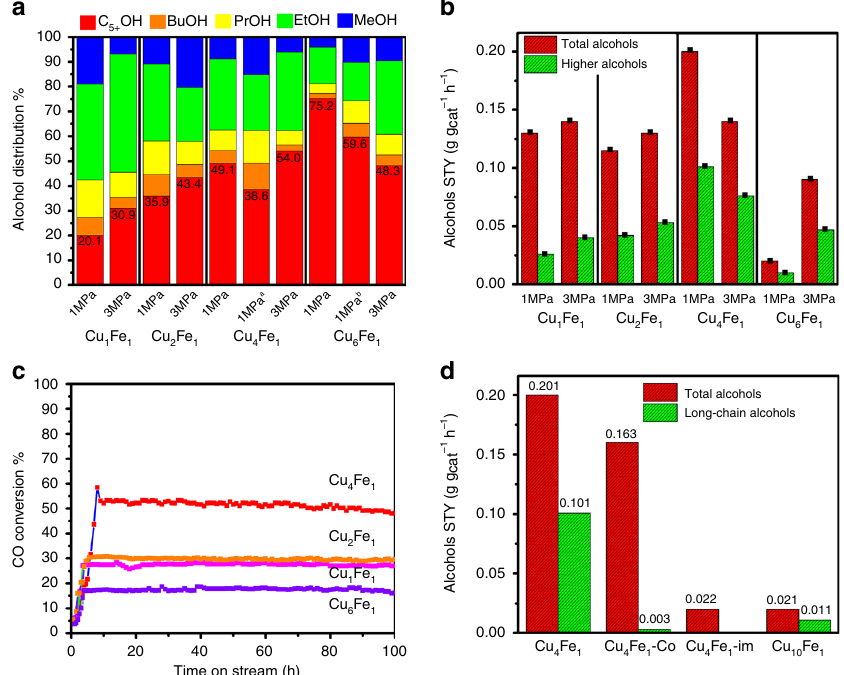
Fig. 2 Catalytic performance. a Alcohol distribution normalized data to total alcohols selectivity ( a WHSV = 4800mL g cat − 1 h − 1 ; b WHSV = 1200mL g cat − 1 h − 1 ; C 5 + OH: long-chain alcohols, BuOH: butanol, PrOH: propanol, EtOH: ethanol and MeOH: methanol) and b alcohols STY at different pressures over catalysts with four Cu/Fe ratios (1/1, 2/1, 4/1, and 6/1) (reaction conditions: 27% CO + 55% H 2 + 18% N 2 ; 260 °C; WHSV of 2400 mL g cat − 1 h − 1 ). c Time-on-stream (TOS) evolution of CO conversion over the four catalysts within 100 h test at 1 MPa. d Alcohols STY of Cu 4 Fe 1 , Cu 4 Fe 1 -co, Cu 4 Fe 1 -im, and Cu 10 Fe 1 at 1